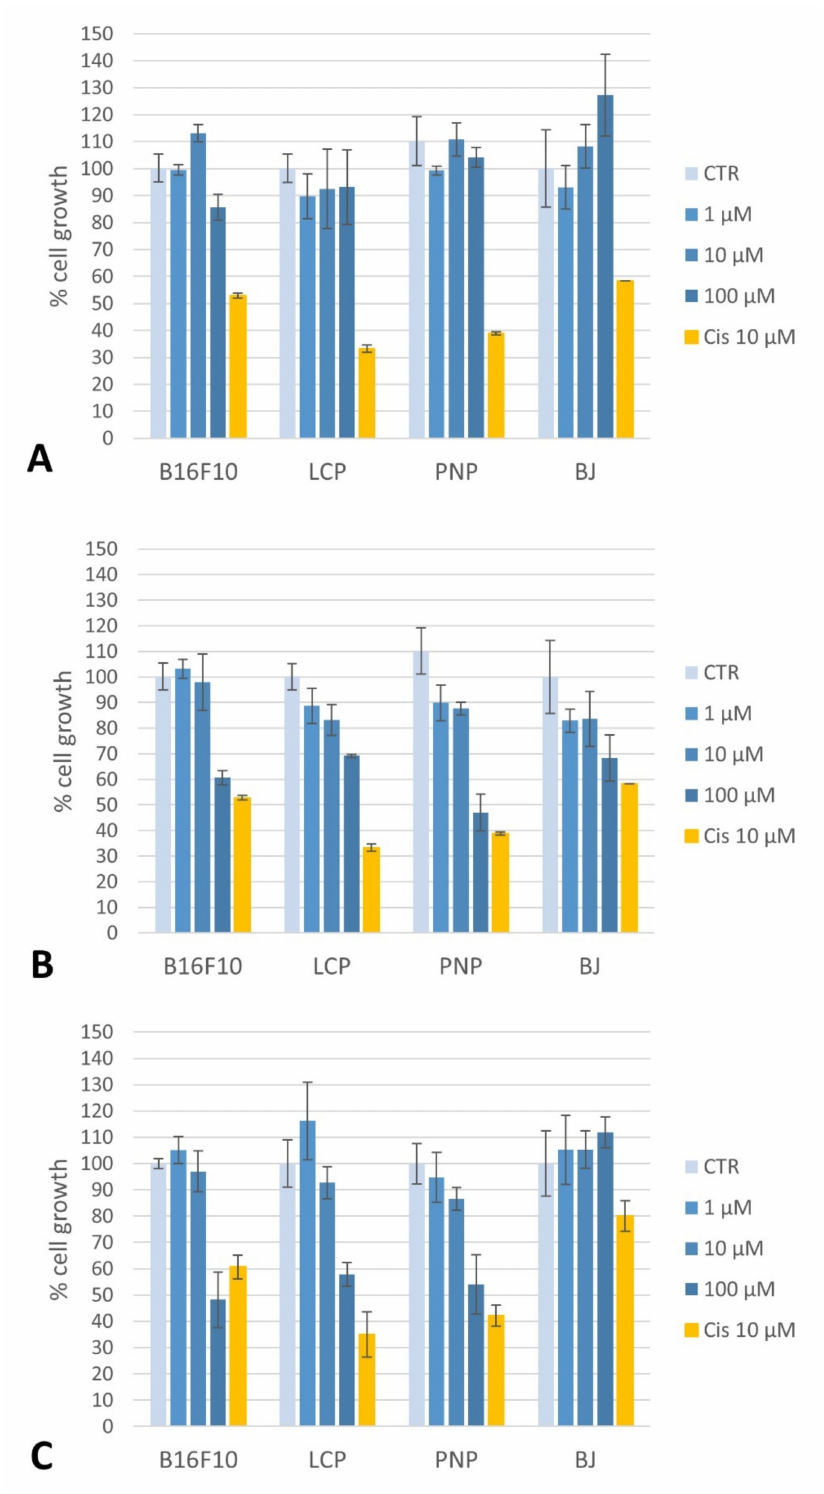
Figure 6. Cytotoxic activity: cells were cultured with increasing concentrations (1, 10, 100 µ M) of compounds 1 ( A ), 6 ( B ) or 7 ( C ) up to 48 h. 10 µ M Cisplatin (Cis) was used as toxicity positive control. Cell proliferation values were calculated as growth percentages of treated cells compared to the untreated ones (CTR). Graphs represent the results of three experiments, each done in